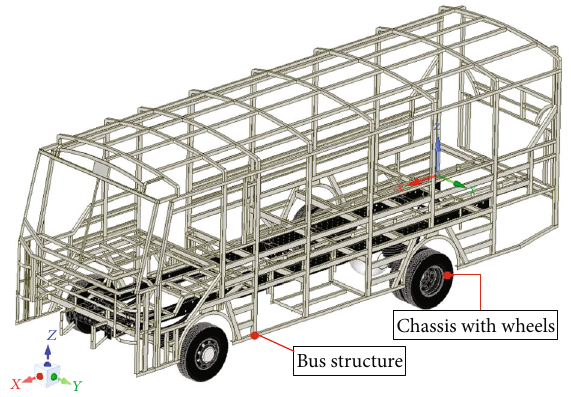
Figure 1: 3D geometry of the bus existing structure and chassis with